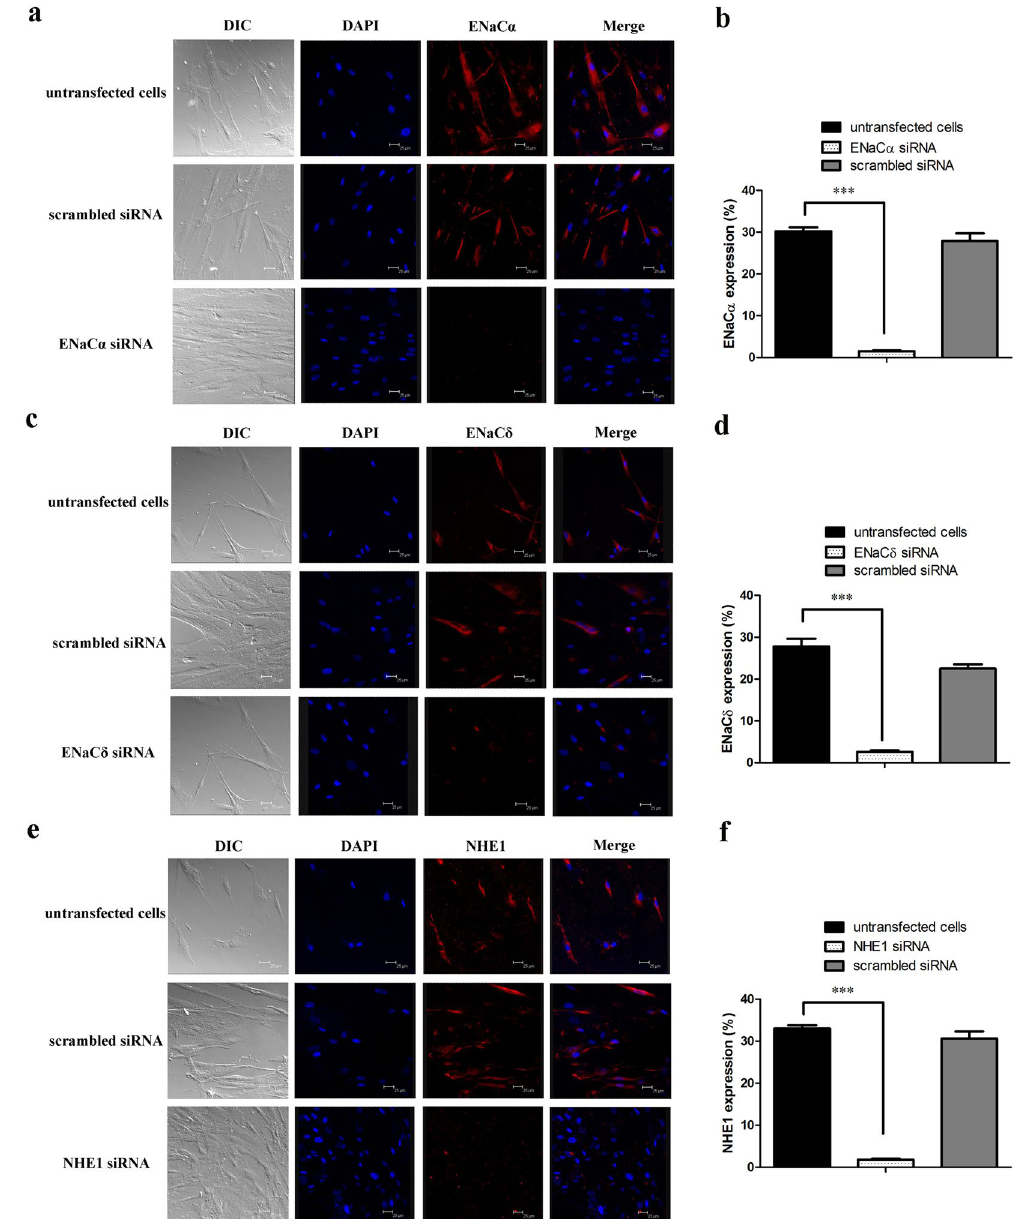
Figure 6. ENaC α , ENaC δ , and NHE1 protein expression in transfected and untransfected cells. ENaC α , ENaC δ , and NHE1 are visualized with a red color; nuclei are stained with a blue color. (a) HBO cells express ENaC α proteins. (b) Percent cells expressing ENaC α in untransfected cells (30.2%, 88 of 291 cells), ENaC α siRNA transfected cells (1.5%, 5 of 327 cells), and scrambled siRNA- transfected cells (27.9%, 69 of 247 cells). (c) The ENaC δ proteins express in HBO cells. (d) Percent cells expressing ENaC δ in untransfected cells (27.8%, 49 of 176 cells), ENaC δ siRNA transfected cells (2.6%, 6 of 232 cells), and scrambled siRNA-transfected cells (22.5%, 29 of 129 cells). (e) Immunoreactivity of NHE1 antibodies demonstrates the presence of NHE1 expression in HBO cells. (f) Percent cells expressing NHE1 in untransfected cells (33.0%, 69 of 209 cells), NHE1 siRNA-transfected cells (1.8%, 5 of 280 cells), and scrambled siRNA-transfected cells (30.6%, 19 of 62 cells). Each experiment was performed three times. * p < 0.05, ** p < 0.01, *** p <